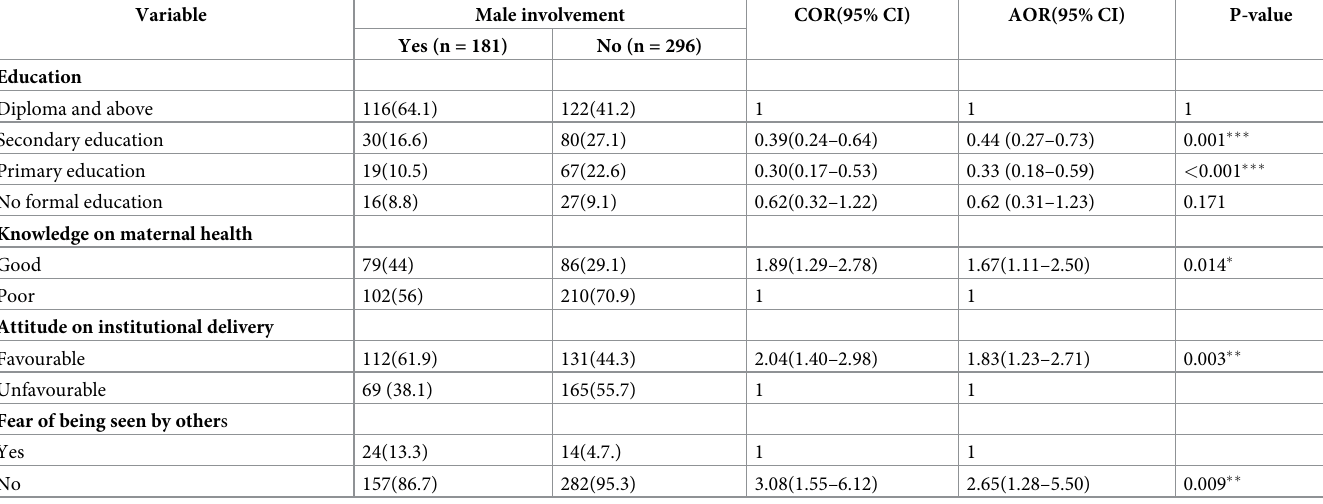
Table 6. Factors associated with male partner’s involvement in institutional delivery at Debre Tabor town North-West Ethiopia, 2019 (n =